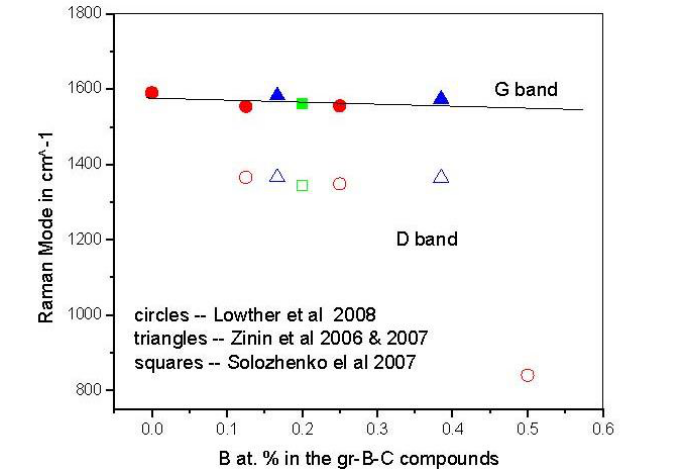
Figure 1. Comparison of vibration energies of the G and D Raman bands in various B–C graphitic structures. Circles are calculations [49], triangles from Zinin et al. [50,51] and squares from Solozhenko et al . [52].